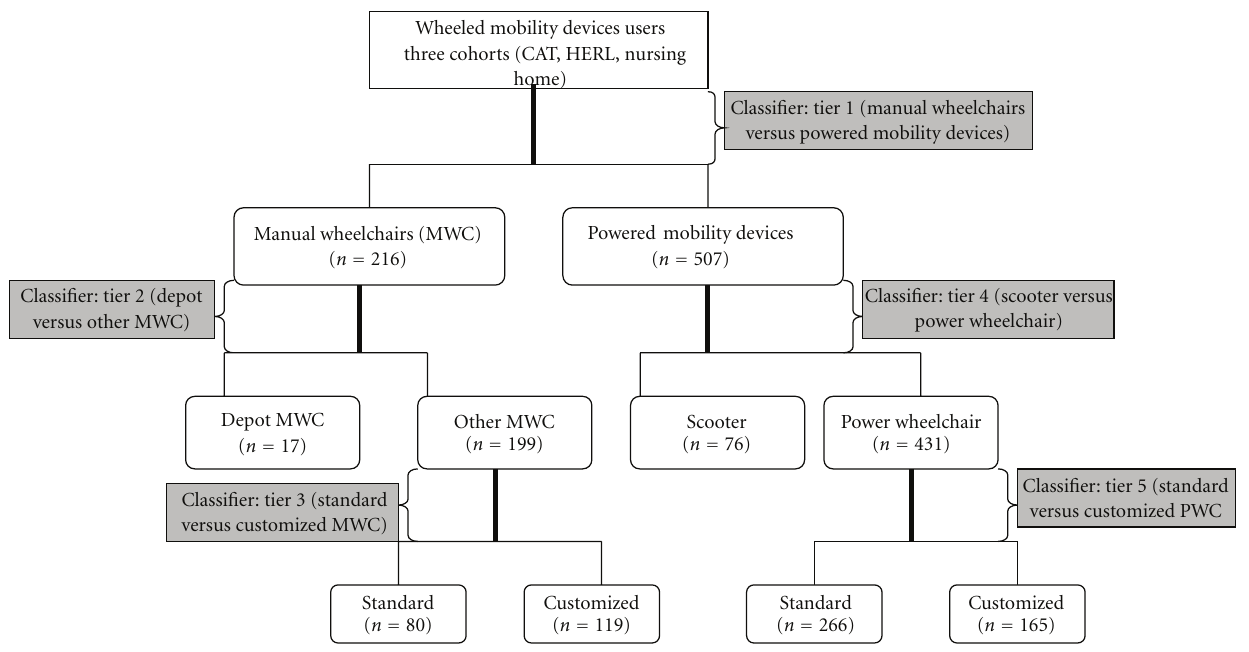
Figure 2: Data stratification